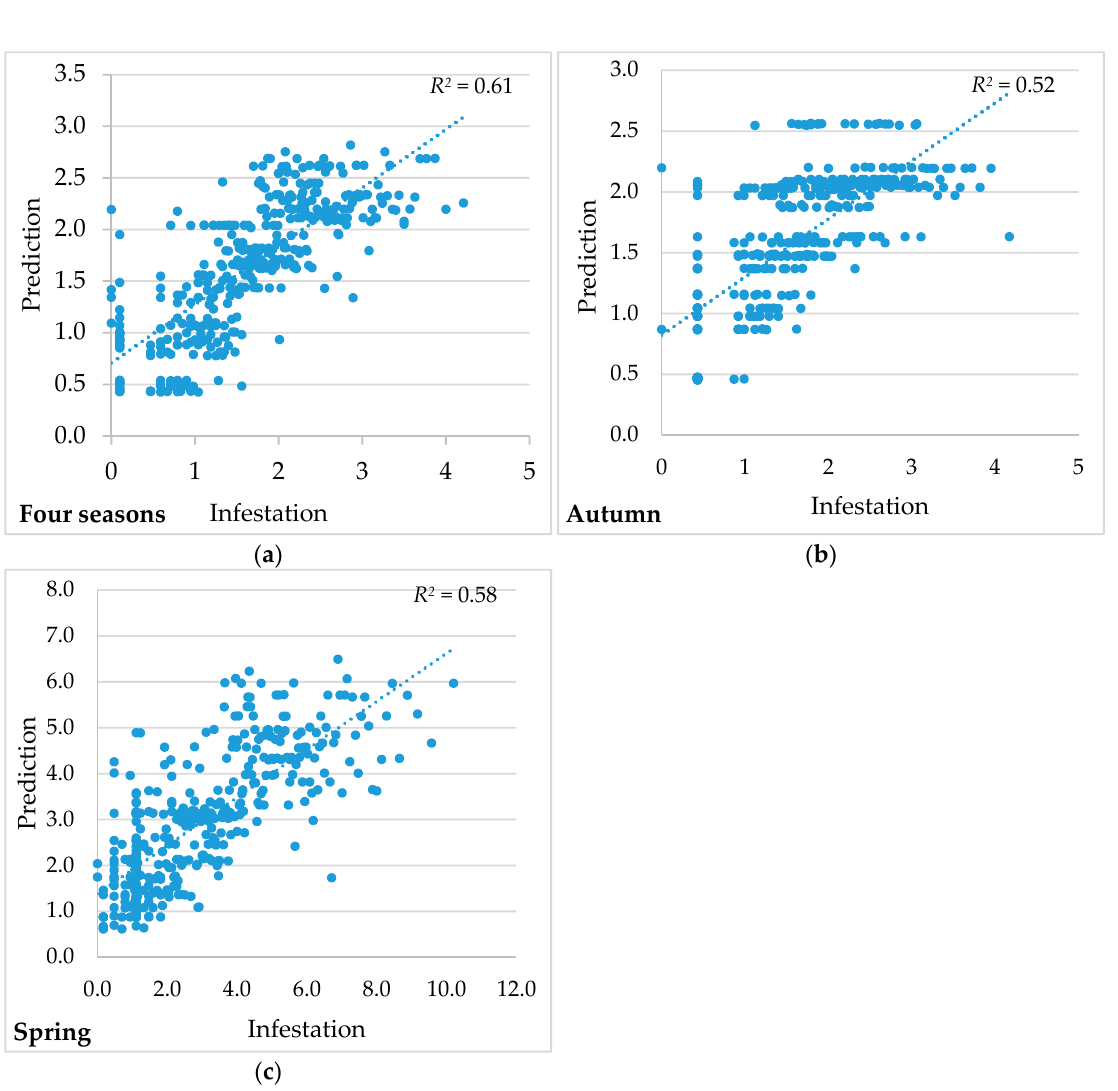
Figure 4. Scatter plot for GWR (geographically weighted regression) model of significant environmental factors for four seasons ( a ), autumn ( b ) and spring means ( c ).